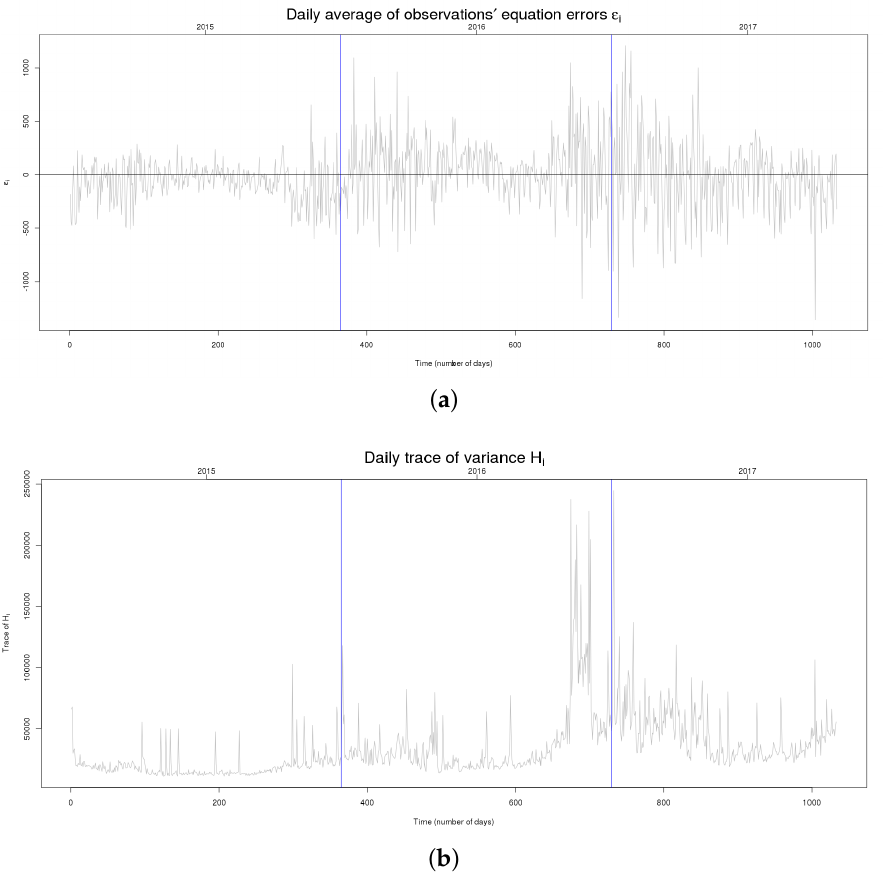
Figure 7. Diagnostics plot from model FSST: ( a ) daily mean of errors ˆ (cid:101) i ; ( b ) daily trace of variance matrix H i